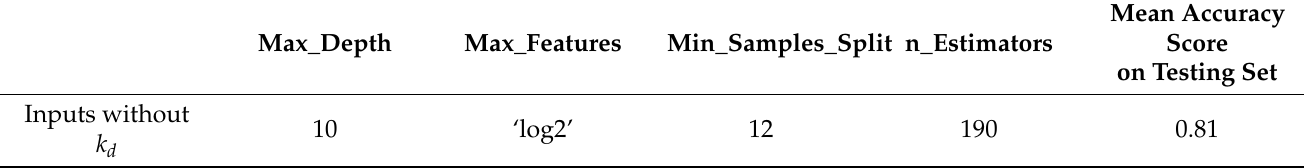
Table 3. Optimal hyperparameters and mean accuracy score of model developed without k d .